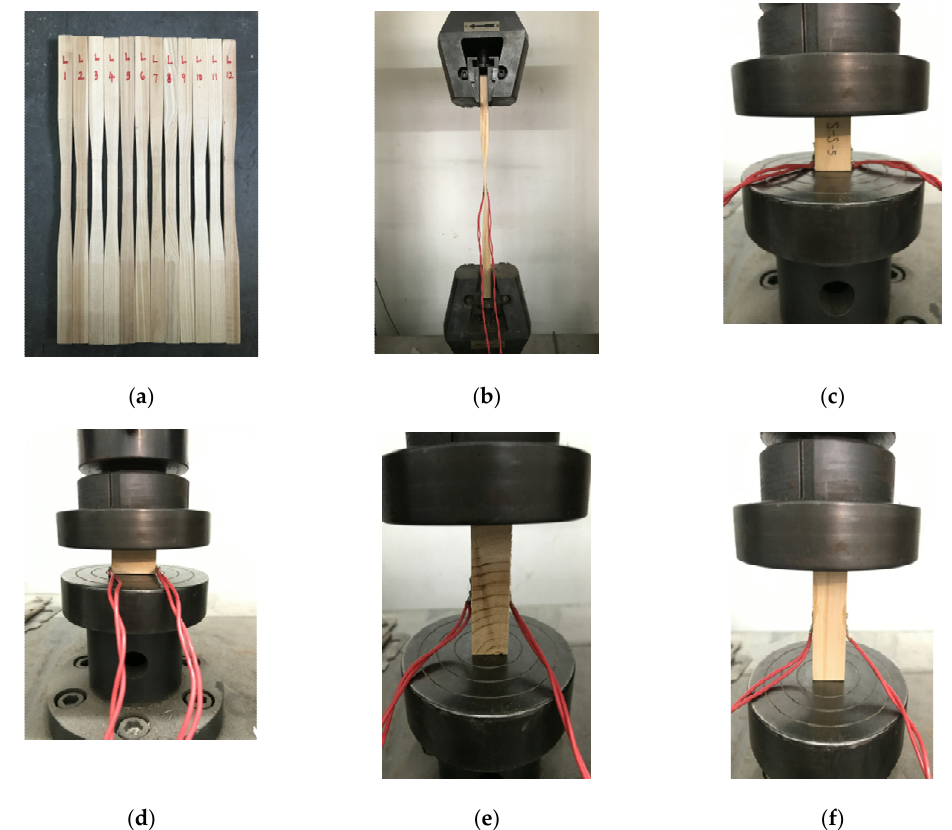
Figure 12. Parameter test of wood physical and mechanical properties: ( a ) tensile specimen; ( b ) tensile test; ( c ) compression specimen along the grain; ( d ) compression test along the radial; ( e ) the modulus of elasticity in compression along the radial; ( f ) the modulus of elasticity in compression along the grain.